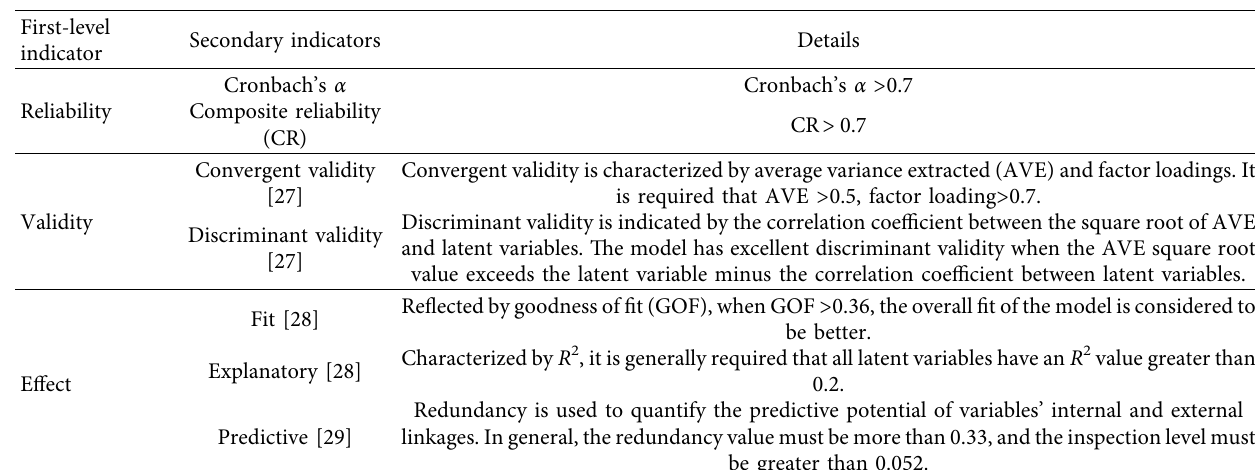
Figure 5: Relationship between variables. Table 2: Evaluation